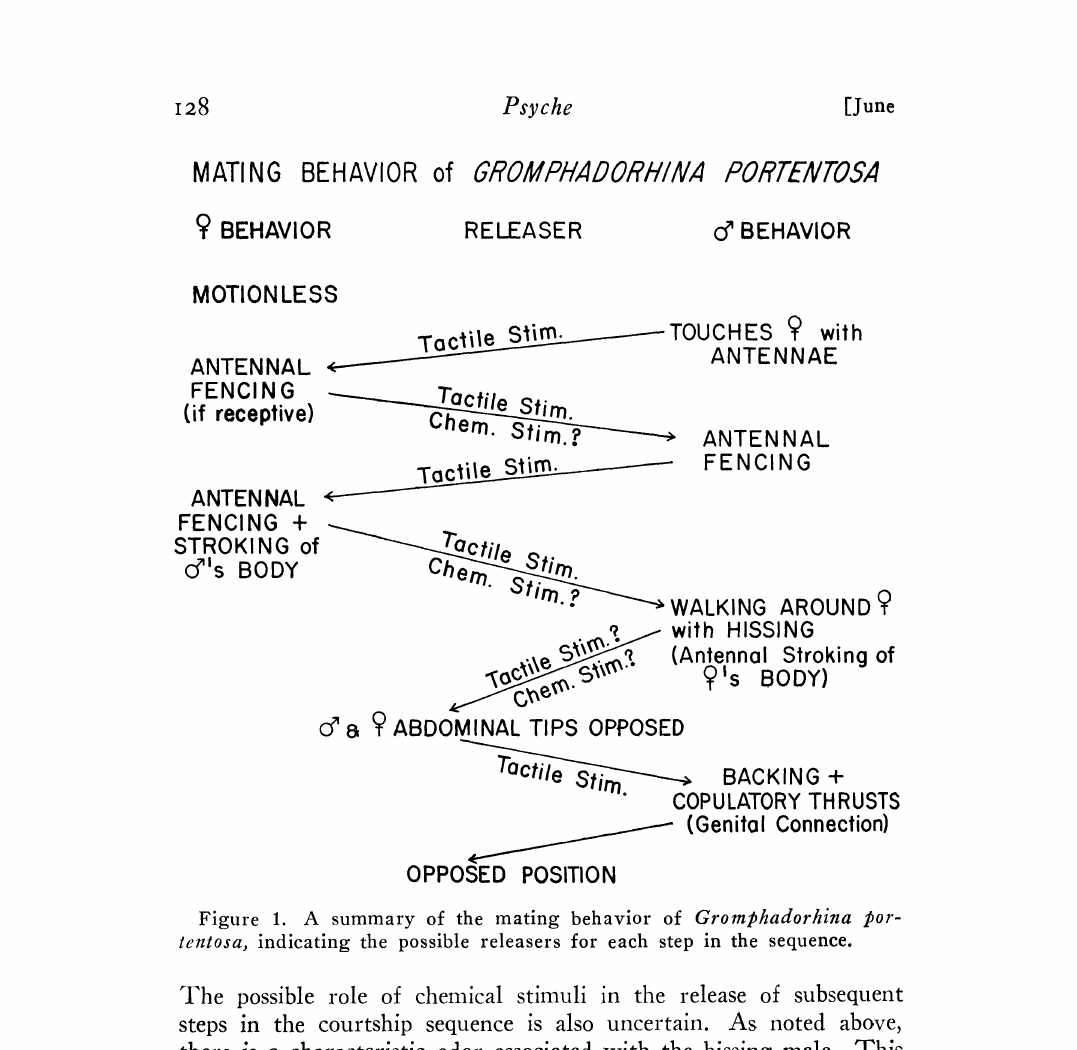
Figure 1. A summary of the mating behavior of GromIhadorhina tor- tentosa, indicating the possible releasers for each step in the